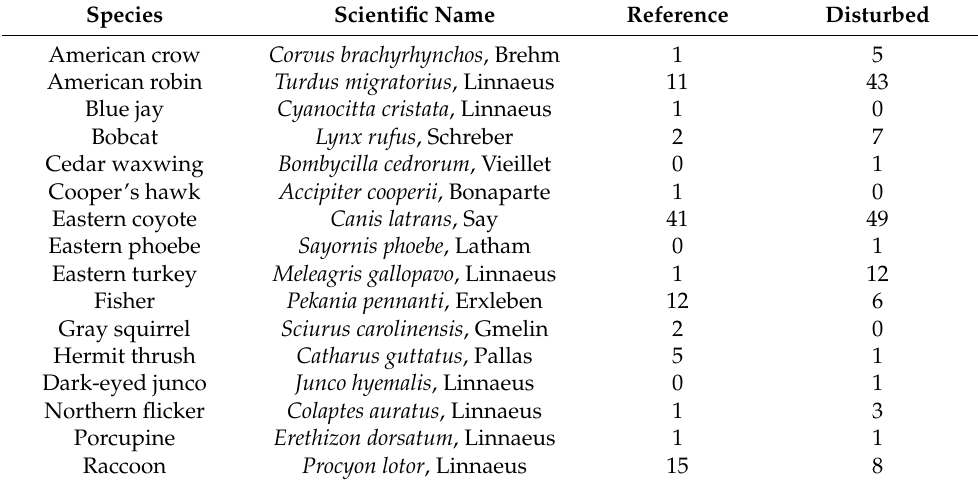
Table A1. Species raw count occurrences for the reference and disturbed